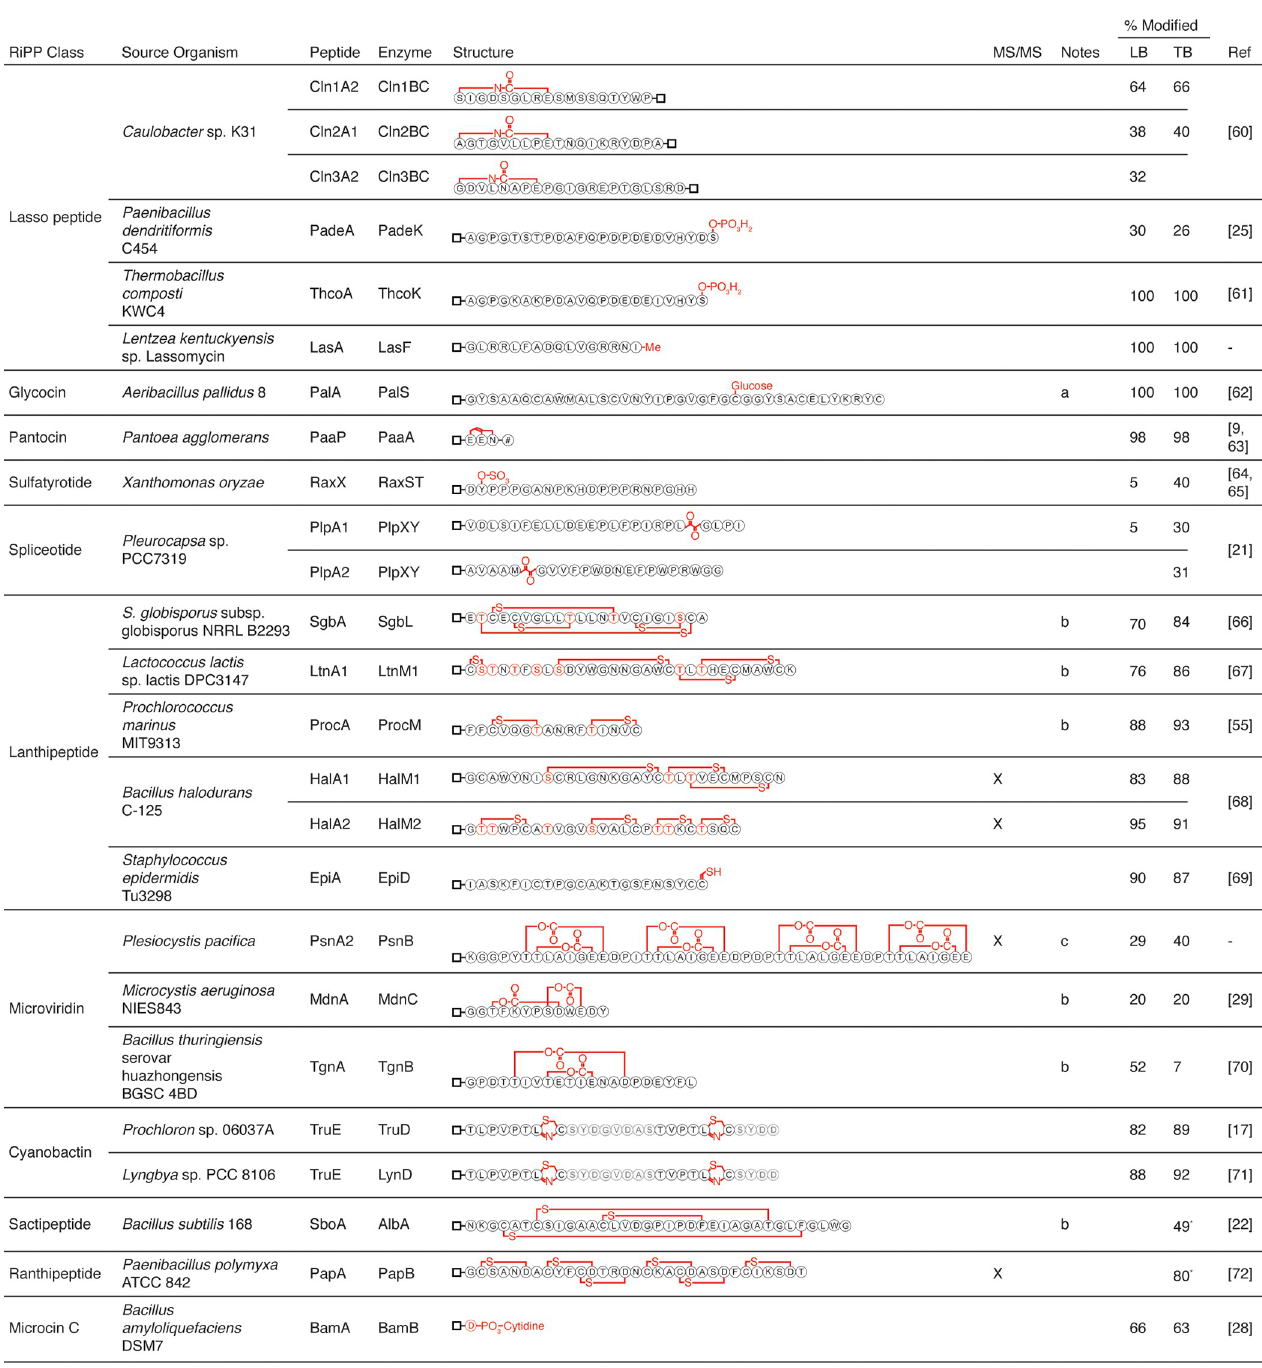
Fig 4. Successfully enzyme-modified peptides. RiPP class, source, gene names, and previously published structure for successfully observed modifications. Modified peptides analyzed with MS/MS are demarcated with an “X” in the MS/MS column. Potential structural ambiguity is listed in the Notes column: Blank —the collected LC-MS or LC-MS/MS data confirms the published structure or is consistent with published data for the structure, a–multiple cysteines present could be glycosylated and cannot be differentiated by LC-MS, b–cross-linking pattern was not validated and could differ from wild-type structure shown, c– MS/MS shows four distinct intra-modified cores, but does not validate cross-linking pattern within each core. Mean percent modified is listed for each modification in LB and TB medias, with individual replicates plotted in S4 Fig. Fraction modified for ThcoA/K is the sum of mono- and di-phosphorylated peptide. Percentages marked with an asterisk ( � ) have a modification with a small mass shift–percent modified may be inaccurate due to isotope overlap between unmodified/modified peptides (SboA/AlbA cleaved spectrum validation in S5 Fig; PapA/PapB in S5 Note). References are listed for modifications that have previously been shown in E . coli